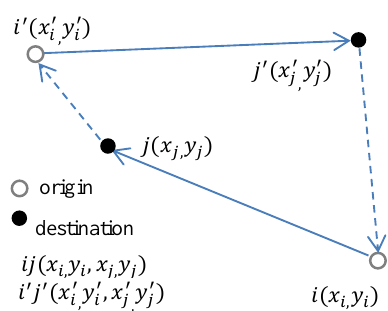
Figure 2. The Euclidean distance between flow(i,j) and flow( i ′ j ′ ).